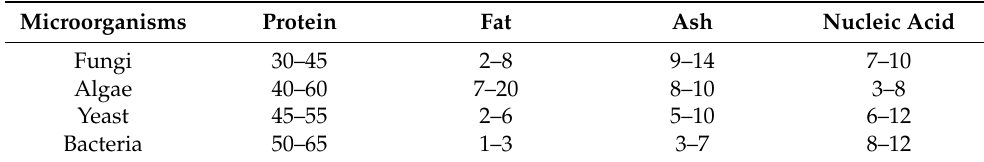
Table 1. Nutritional compositions of microorganisms (% dry weight) (Kalaichelvan and Arul- pandi,